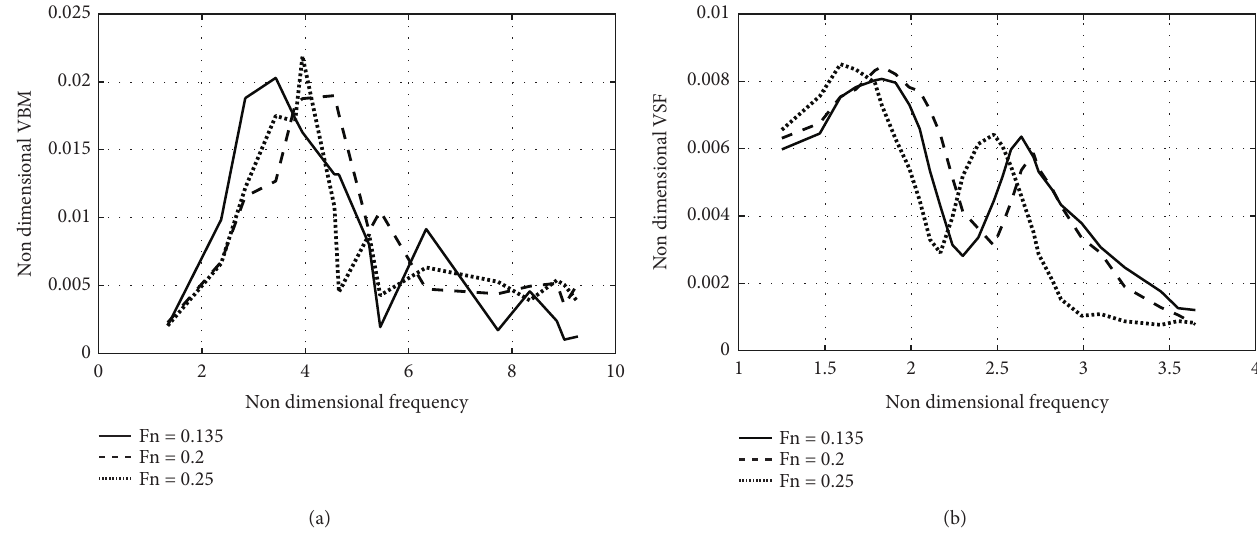
Figure 13: (a) Transfer function for VBM at amidships for different forward speeds of ULC. (b) Transfer function for VSF at amidships for different forward speeds of ULC.